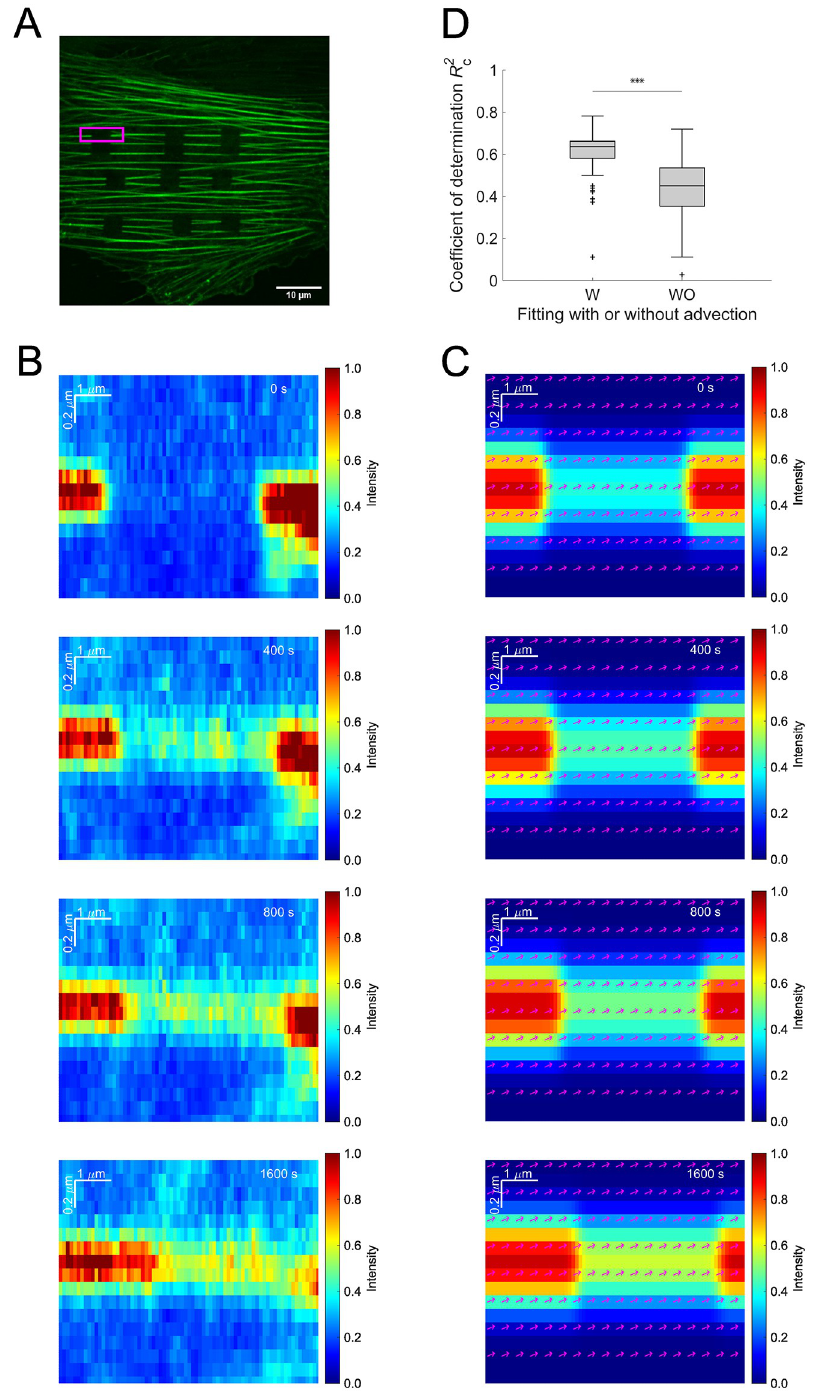
Fig 4. The advection-reaction model fitted to experimental data. (A) FRAP was performed onto SFs in an A7r5 cell, in which mClover2-tagged β -actin is expressed. (B) Experimentally obtained two-dimensional FRAP response of a single SF (rectangular region in A; see S3 Video). (C) The model was fitted with the least-square method to the spatiotemporal evolution of the experimentally obtained FRAP response (see S4 Video). The arrows represent the velocity vectors. Scale, 10 μ m. (D) The coefficient of determination in the regression analysis by using the advection- reaction model with or without the velocity shown by mean ± SD ( n = 66 for each), in which the former case determines all parameters θ = ( K 0 , k off , U x , U y ), whereas the latter case does θ = ( K 0 , k off , 0, 0).